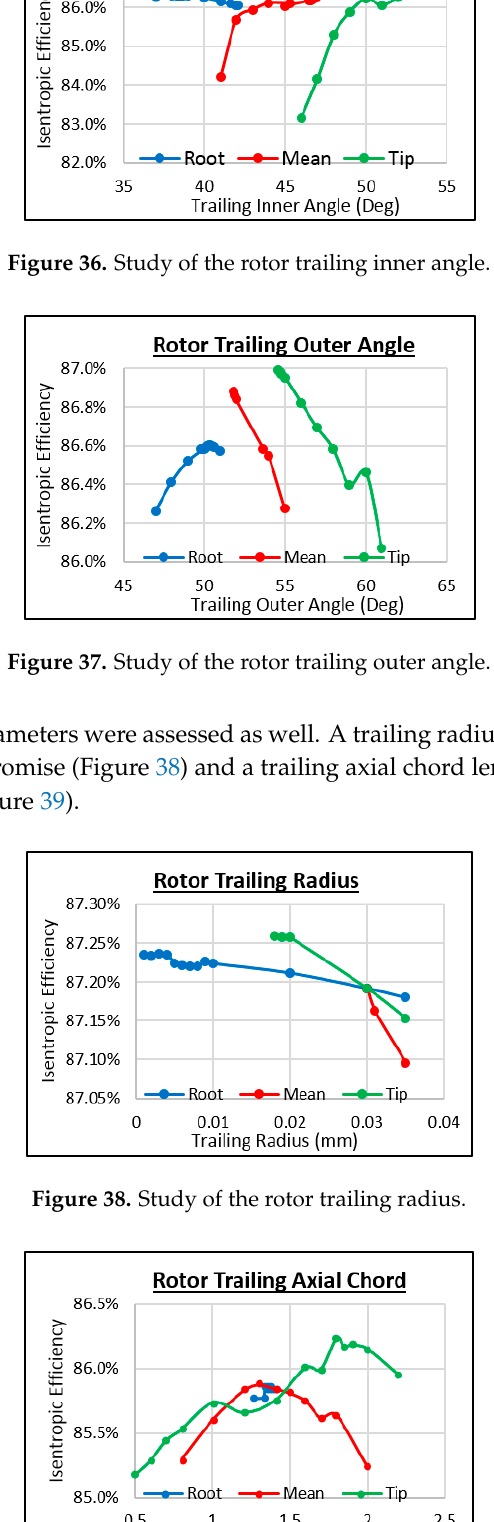
Figure 39. Study of the rotor’s trailing axial chord.